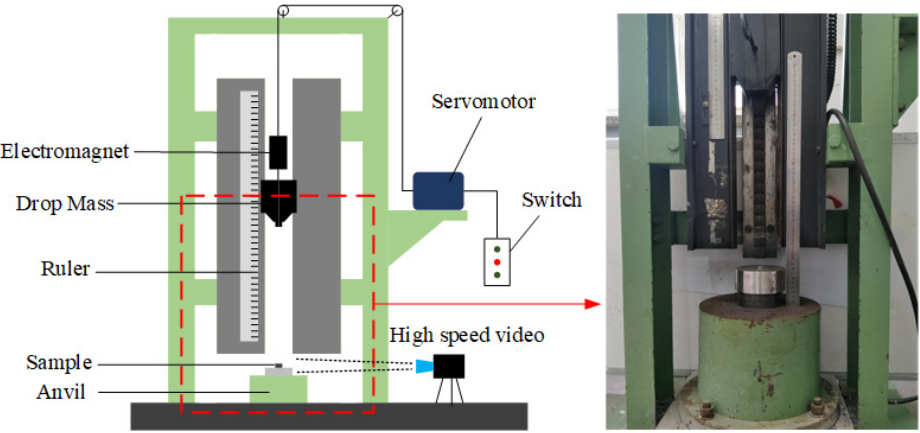
Figure 2. The schematic of the drop-weight apparatus.